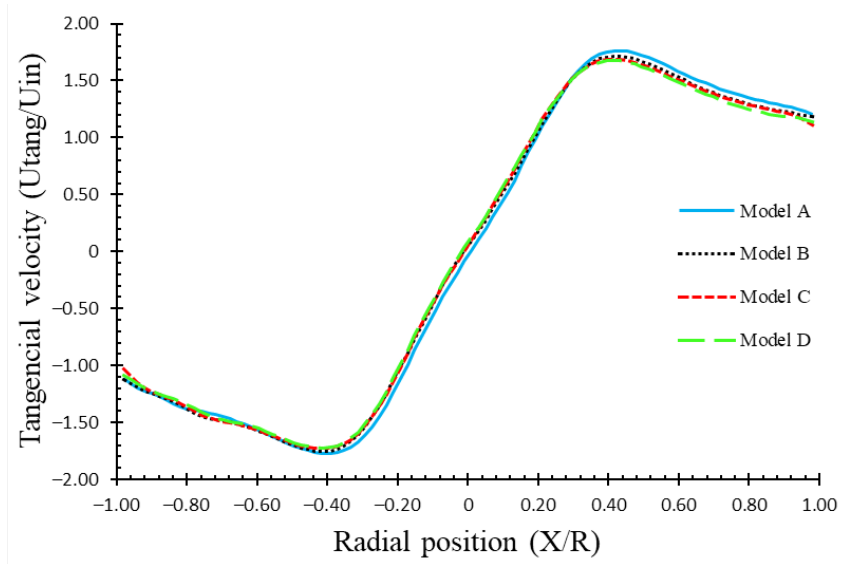
Figure 7. Tangential velocity profiles of cyclone models A, B, C y D.